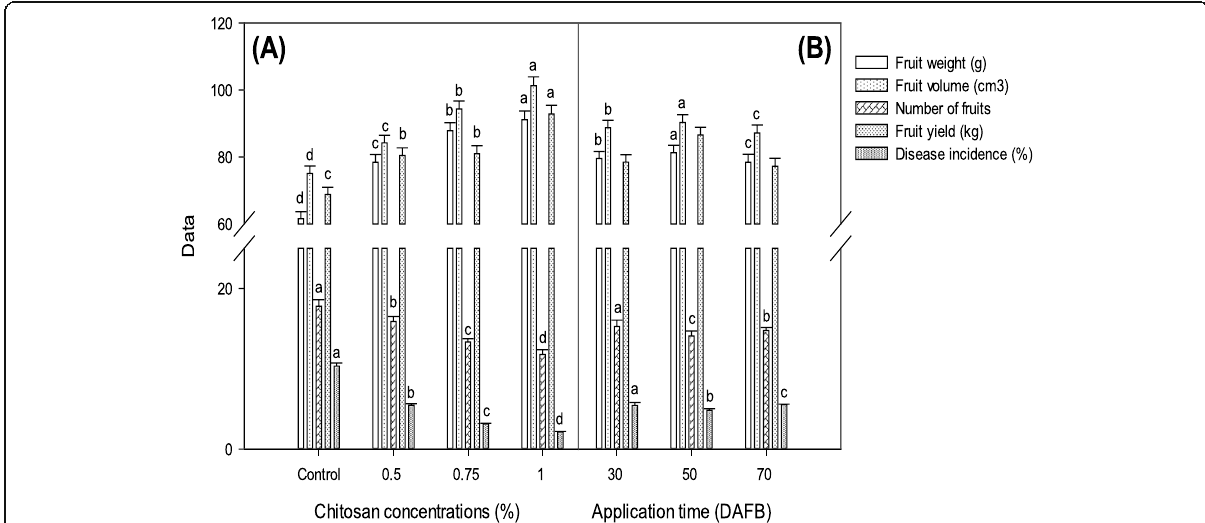
Fig. 1 Fruit weight, fruit volume, number of fruits, fruit yield kg − 1 , and disease incidence of peach as influenced by different chitosan concentrations and application time. The vertical bars represent standard error. Different letters next to the mean values in each bar indicate a significant difference (LSD p ≤ 0.05)